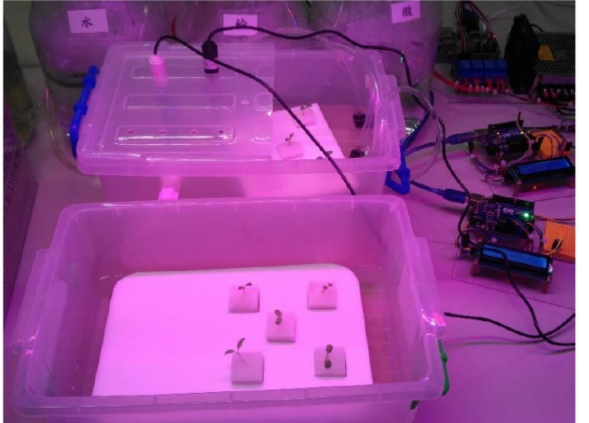
Figure 7. Planted in the system.